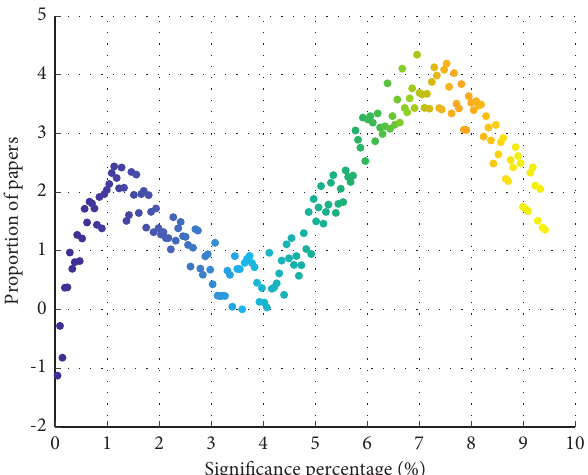
Figure 8: Scatter plots of the distribution of co-lead collaborative research output in relation to the percentage of new keywords.